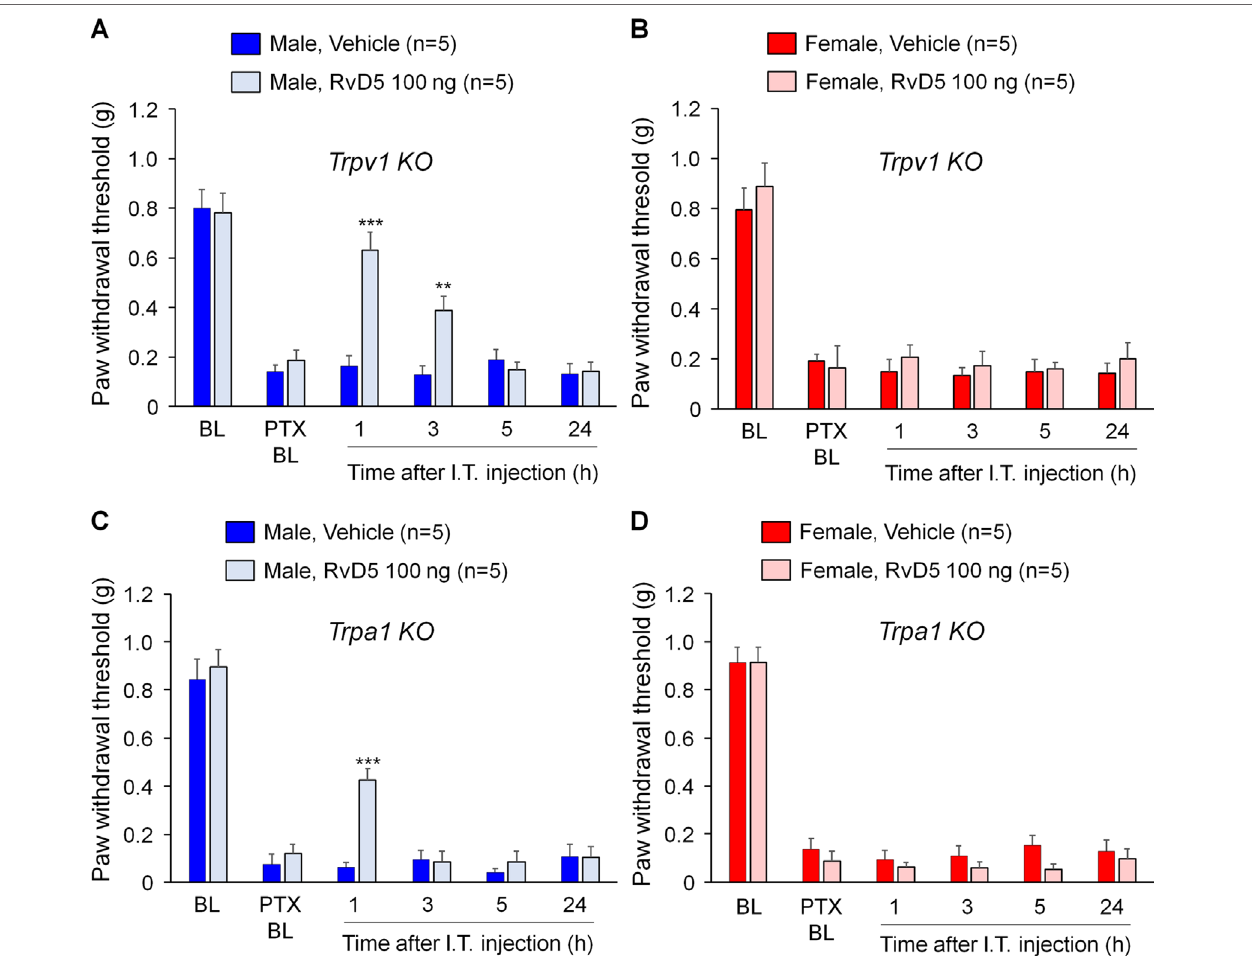
FIGURE 3 | Effects of intrathecal RvD5 on PTX-evoked mechanical allodynia in male mice (A, C) and female mice (B, D) lacking Trpv1 (A, B) and Trpa1 (C, D) . RvD5 (100 ng, i.t.) was able to inhibit mechanical allodynia in male TRPV1-KO mice (A) and male TRPA1-KO mice (C) , showing no effects on female mice (B, D) . **p < 0.01, ***p < 0.001, vs. vehicle. Two-way ANOVA with Bonferroni’s post hoc test, n = 5 mice per sex per